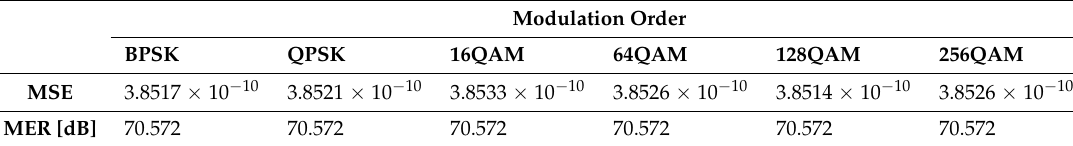
Table 3. MSE and MER for several different modulation schemes.